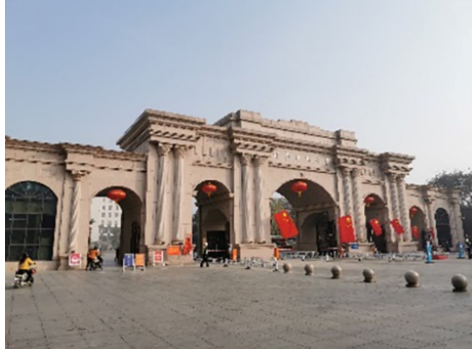
Figure 11. Original image.